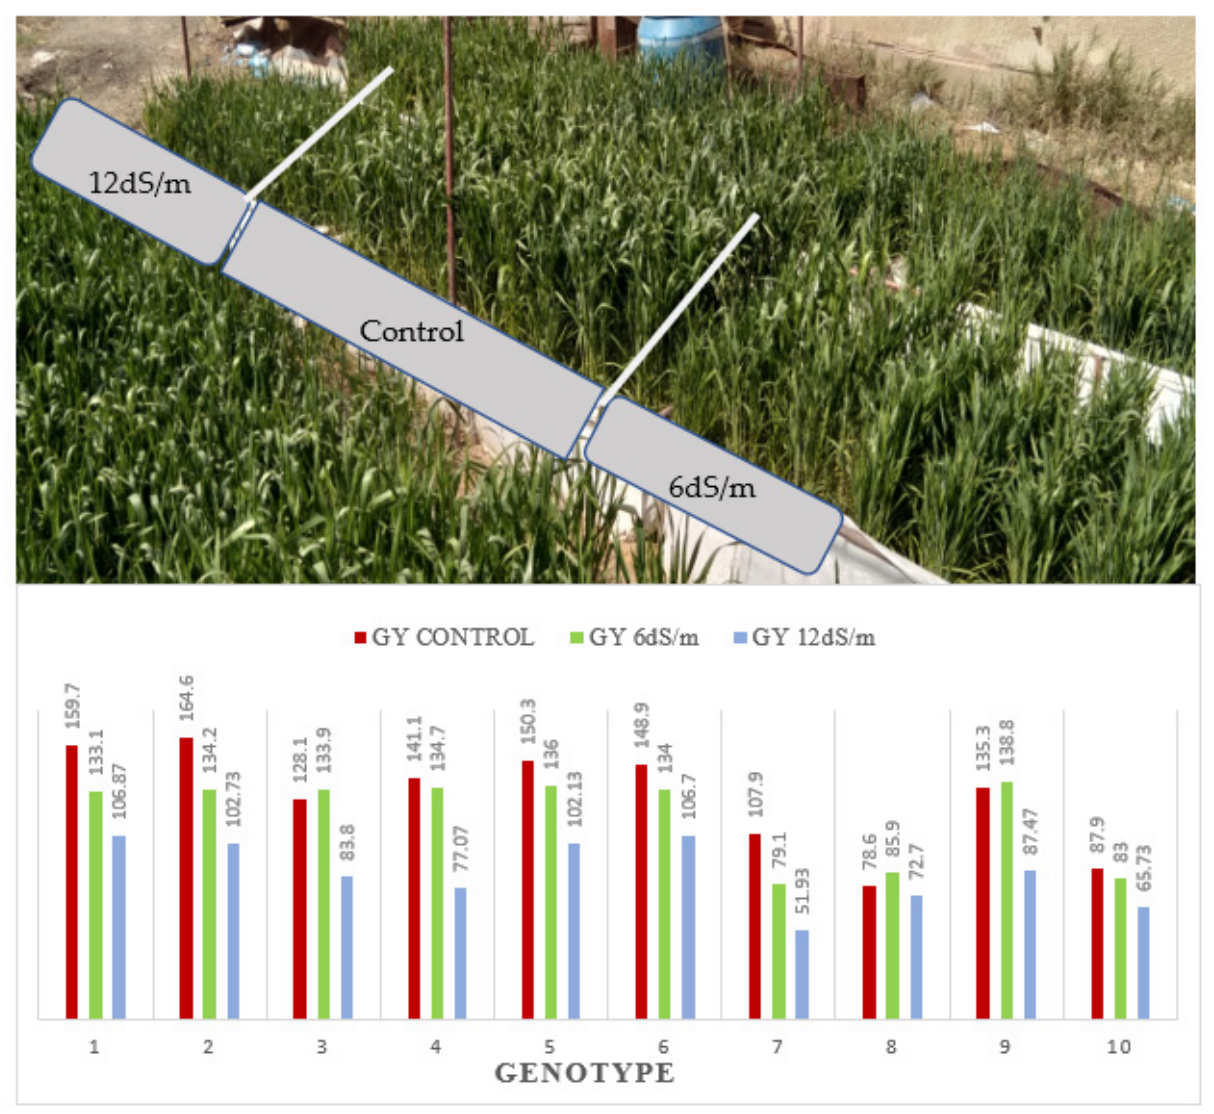
Figure 9. Bar plot for ten wheat genotypes grain yield gm per row (GY) evaluated in simulated lysimeter grown under 0.4, 6.0, and 12.0 dS/m diluted seawater in the 2020/21 season. Table 8. Grain yield gm per row and salinity tolerance/susceptible indices, along with grain yield combined data gm per row (GYC) of ten wheat genotypes grown at control at 0.4 dS/m (GYN) or at 6.0 and 12.0 dS/m diluted seawater in 2020/21 Season. 6.0 dS/m